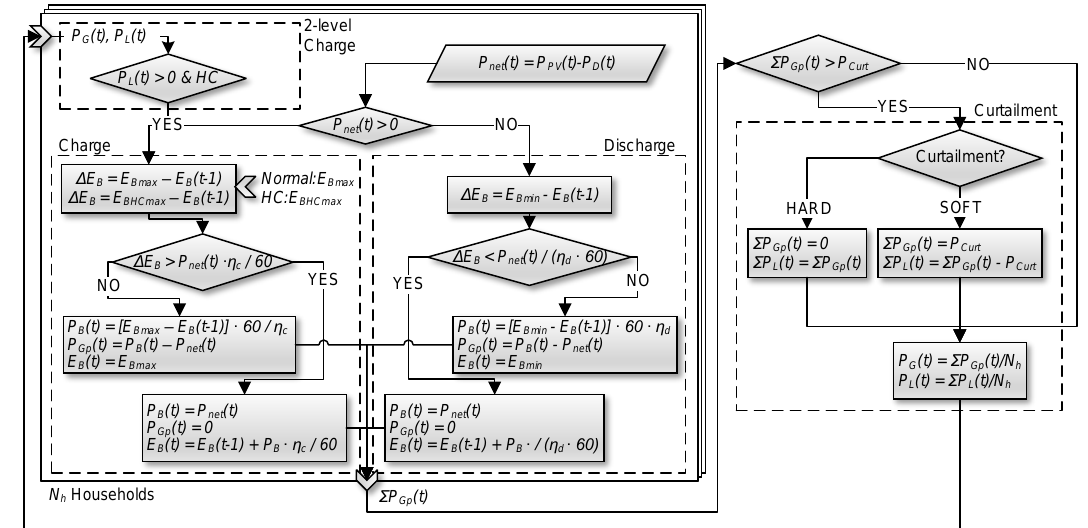
Figure 3. Flowchart of the interaction between the PV generation, the demand, the storage system and the main